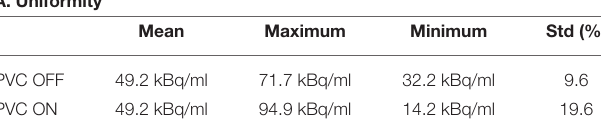
TABLE 1 | NEMA IQ results.